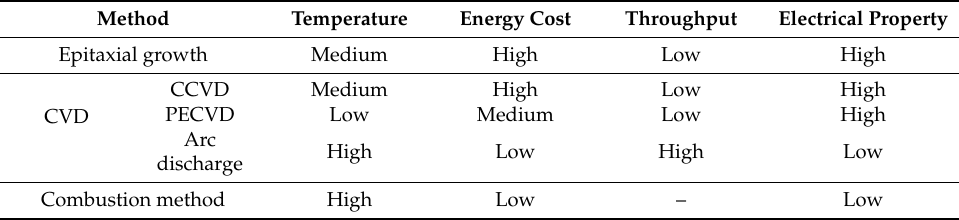
Table 4. A comparison of each growth technique in comprehensive condition.